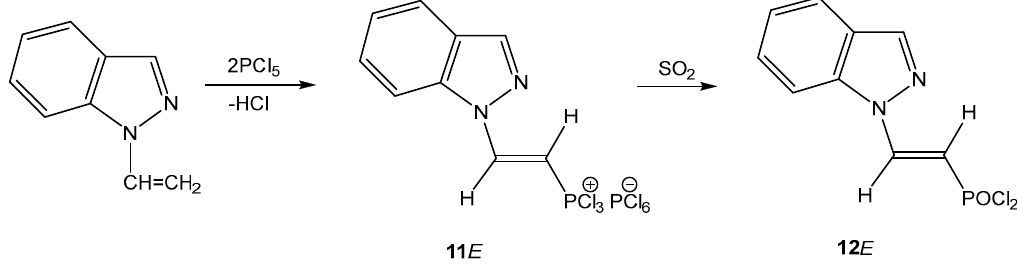
Scheme 2. The phosphorylation of 1-vinylindazole.